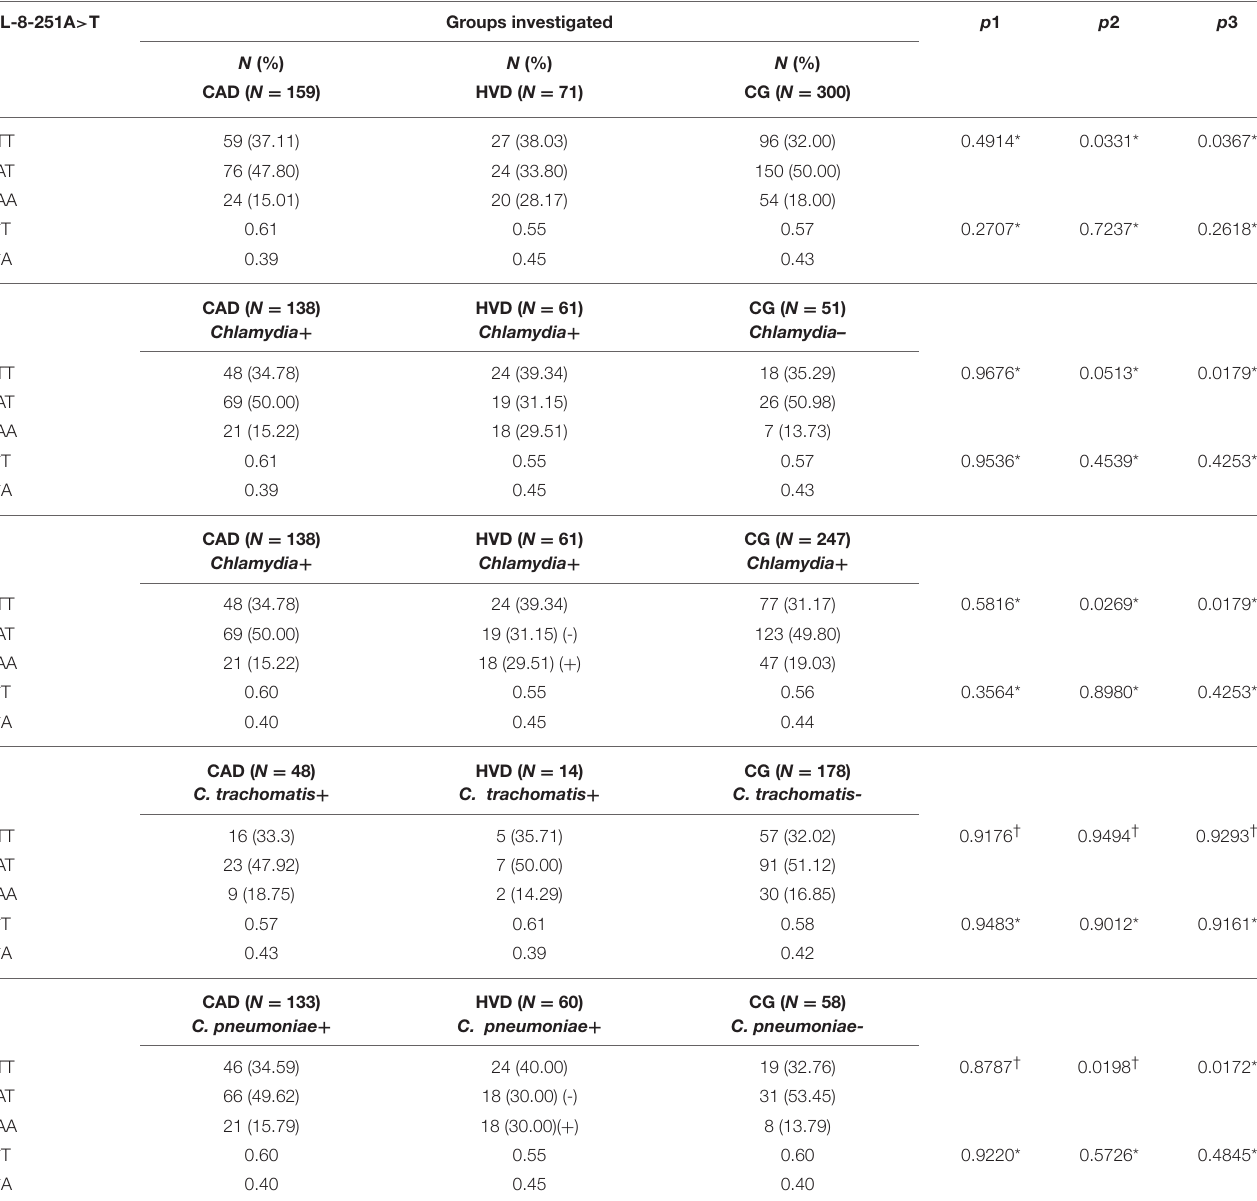
TABLE 5 | Genotypic and allelic distribution of IL-8- 251A > T markers among cardiac patients according to the presence of antibodies to Chlamydia and to the C. trachomatis and C. pneumoniae species. IL-8-251A > T Groups investigated p 1 p